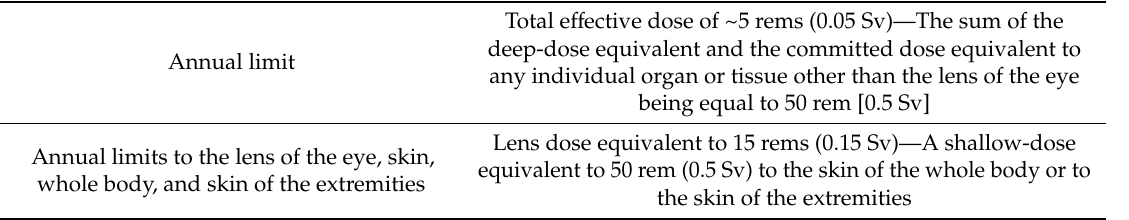
Table 2. Radiation dose limits